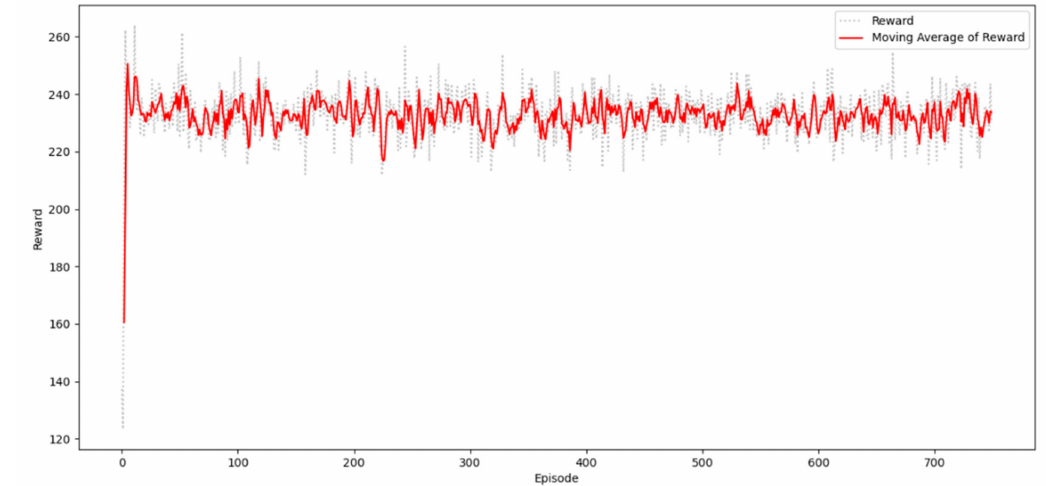
Figure 6. DQN performance on finding the optimal truck